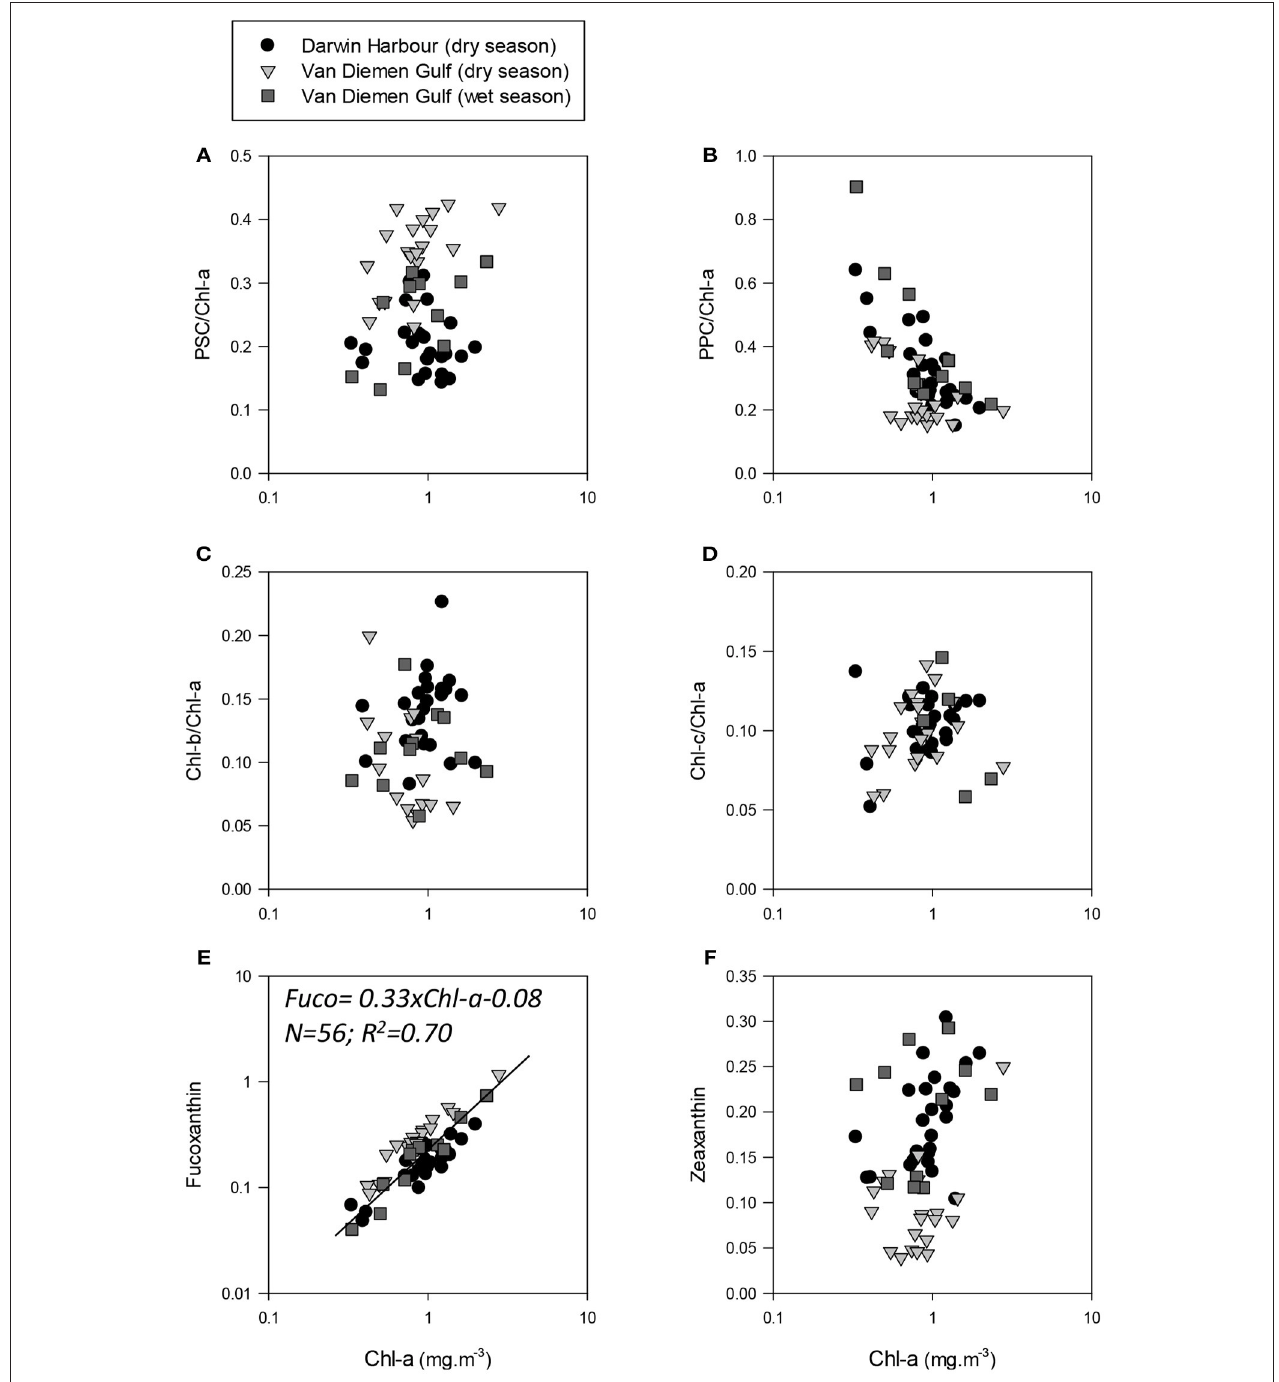
FIGURE 11 | Photo-acclimation and photo-adaptation processes in the NMR. Pigment ratios as a function of Chl-a. (A) photosynthetic carotenoids to Chl-a ratios; (B) non-photosynthetic carotenoids/Chl-a ratios; (C) Chl-b to Chl-a ratios; and (D) Chl-c to Chl-a ratios. Fuxoxanthin and zeaxanthin as a function of Chl-a are shown in (E,F) ,